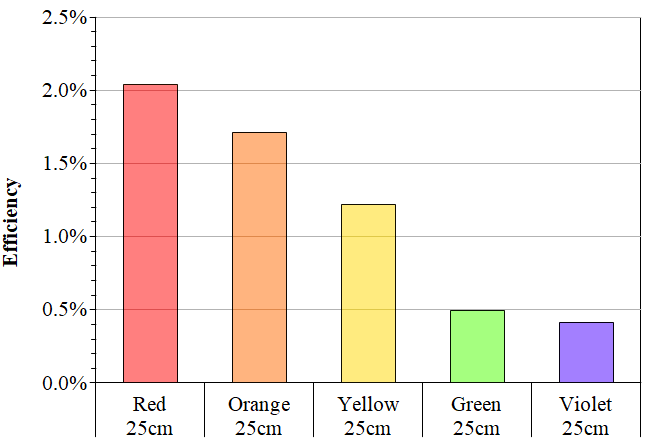
Figure 17. Efficiency of square LSC panel (25 cm side) functionalized by using different dyes of the Lumogen ® F family at 300 ppm.